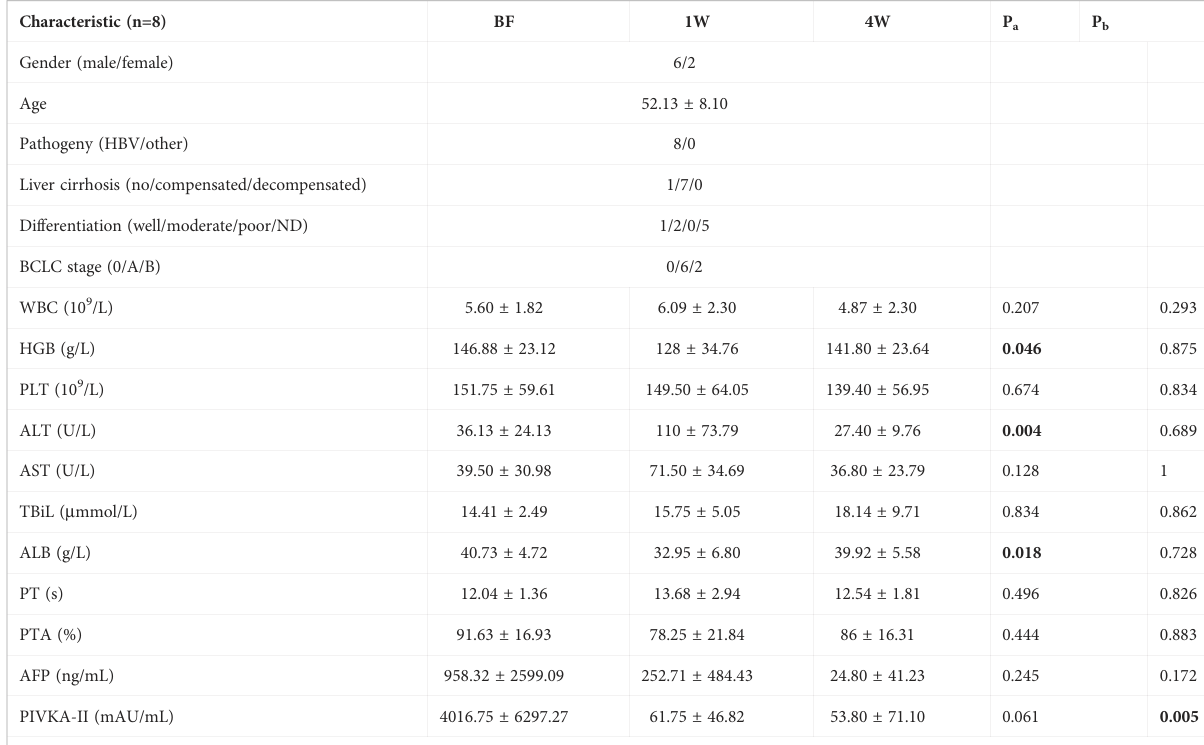
TABLE 3B Characteristics of patients who was detected the BF:1W:4W matched CD8+CD39+ T cells. Characteristic